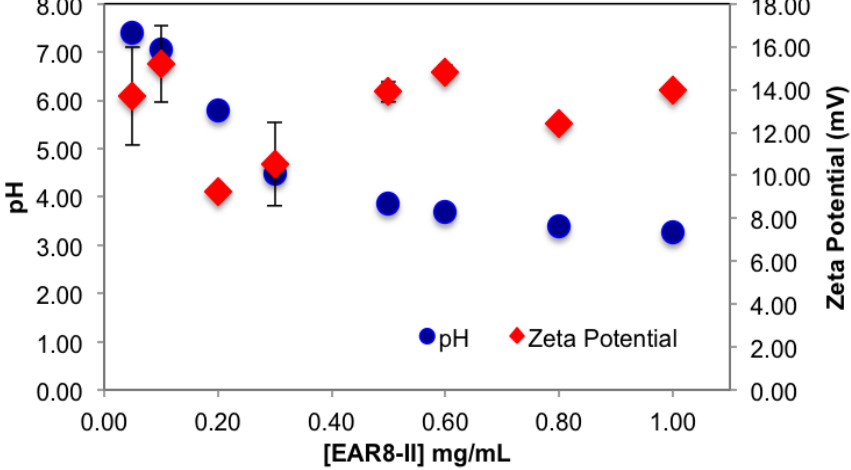
Figure 5. Zeta potential and pH of complex at fixed [THP] = 0.1 mg/mL and varied